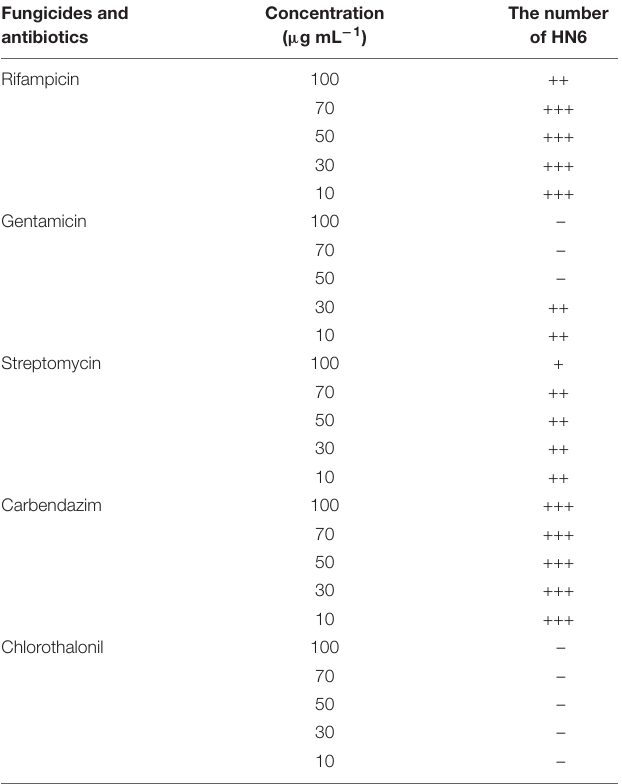
TABLE 1 | Resistance of strain HN6 to antibiotics and fungicides. Fungicides and antibiotics